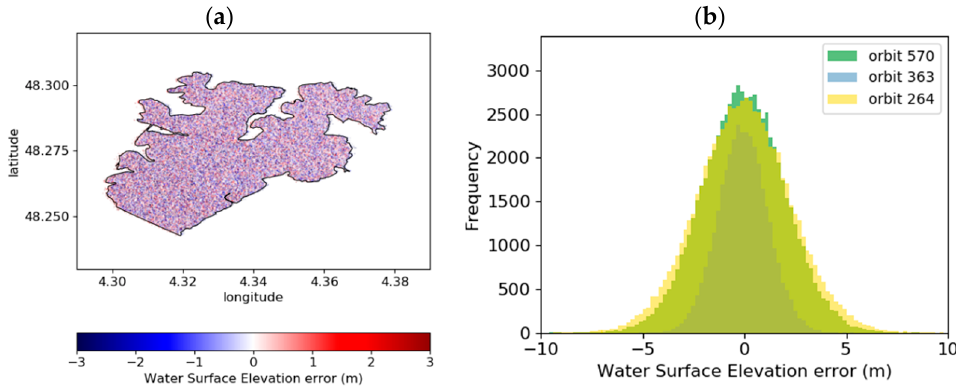
Figure 2. SWOT-like errors simulated for the Orient reservoir: ( a ) pixel cloud of the errors simulated for one date (Orbit 264, day 9 of the simulation); ( b ) histogram of the pixel errors for the three orbits covering the Orient reservoir calculated over one repeat cycle (i.e., for days 9, 13 and 20 of the simulation).